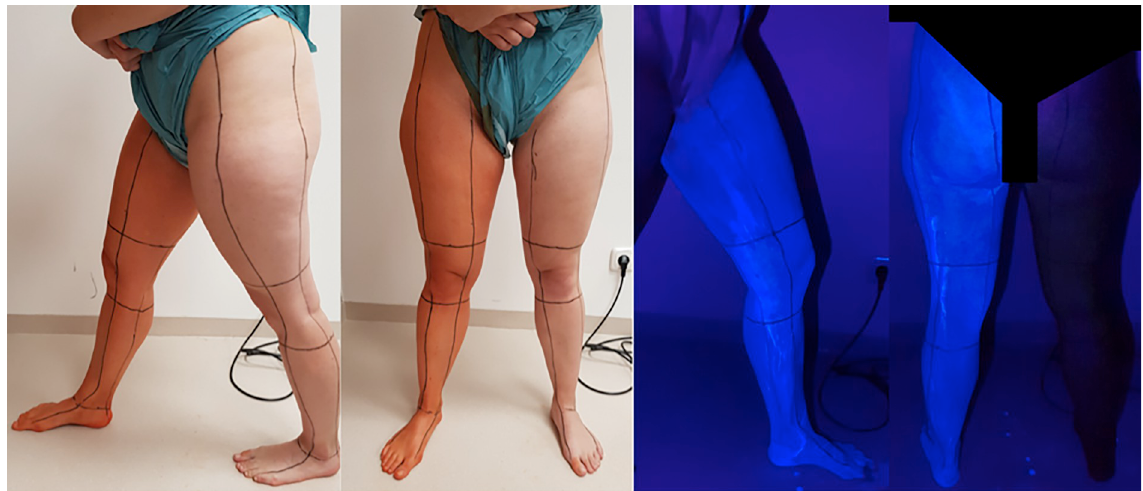
Outcomes The primary outcome of interest was the number of legs with an incomplete scrubbed area. An incomplete skin cleansing area was defined as any visibly not disinfected skin part regardless of size. The secondary outcome was the cumulative size of these areas measured in square centimeters.